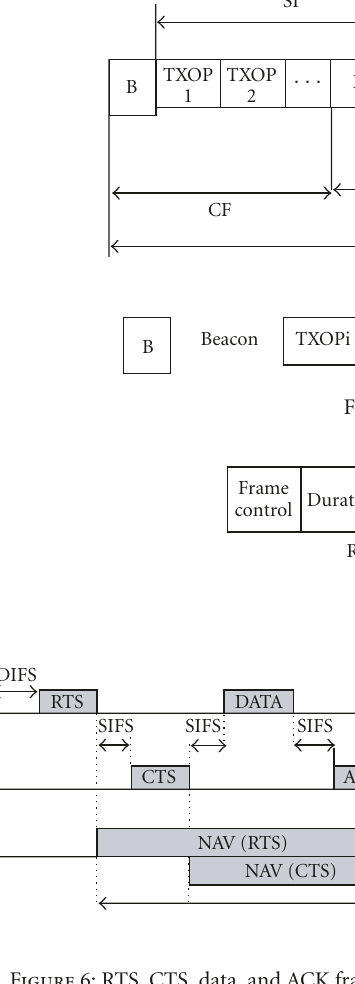
Figure 6: RTS, CTS, data, and ACK frames sequence.